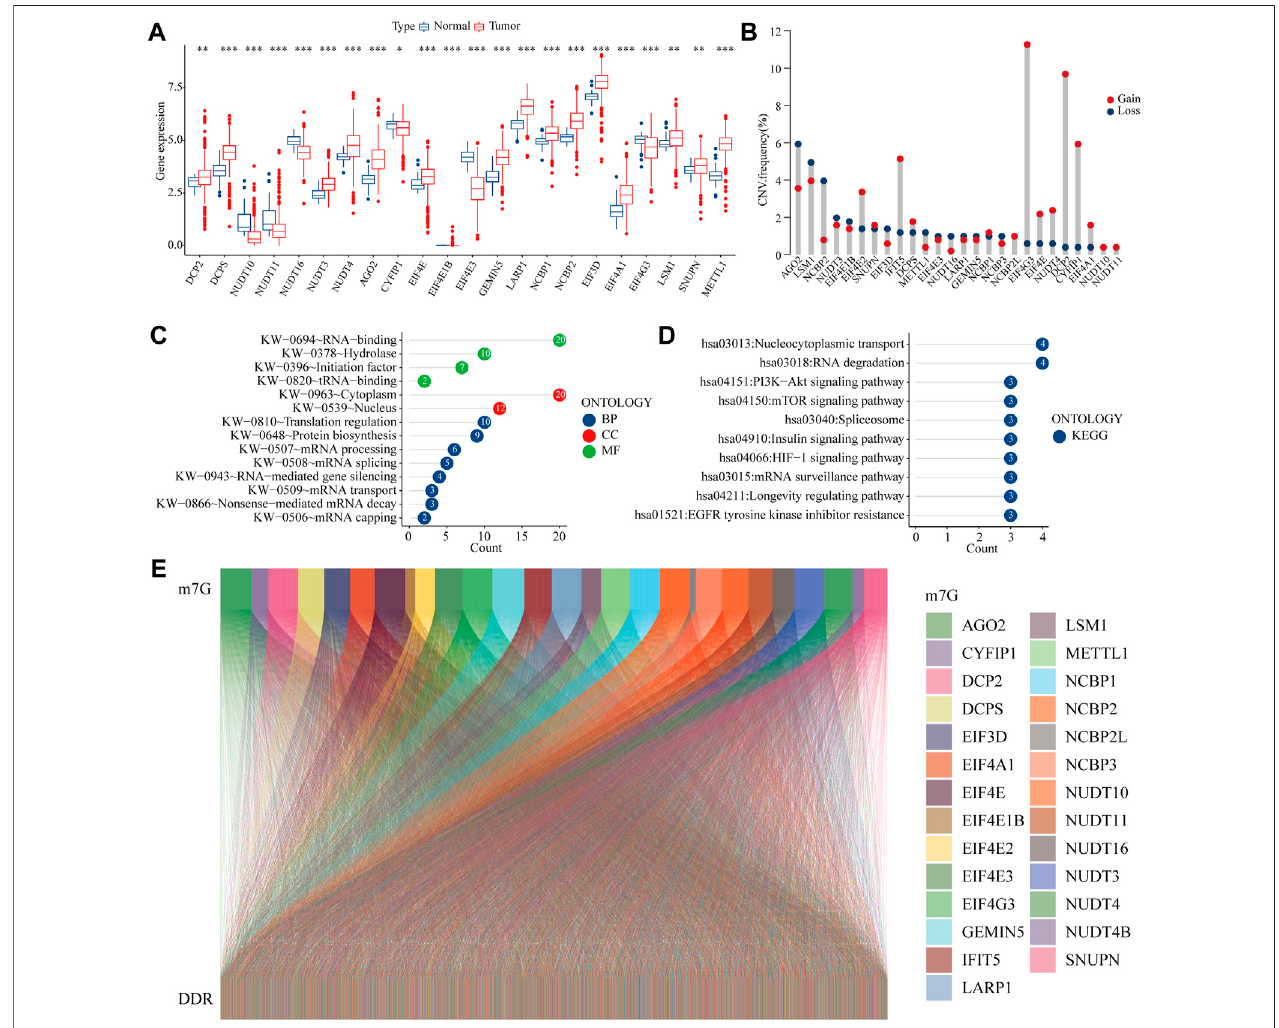
FIGURE2| m 7 GrelatedDDRgene (A) Expressionofm 7 G-relatedgenesinCOADandnormaltissues (B) Mutationfrequencyofm 7 G-relatedgenes (C – D) GOand KEGG analysis of m 7 G-related genes (E) Co-expression relationship between the m 7 G gene and DDR gene.